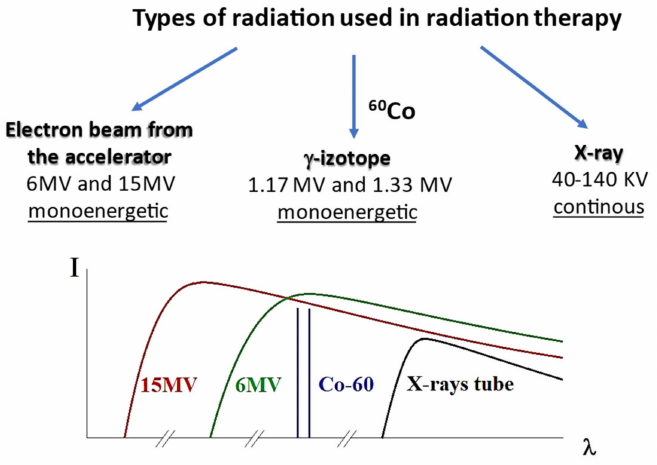
Figure 3. Different types of radiation used in this work ( top ); the schematic dependence of wavelength λ of X-rays on the type of radiation ( bottom